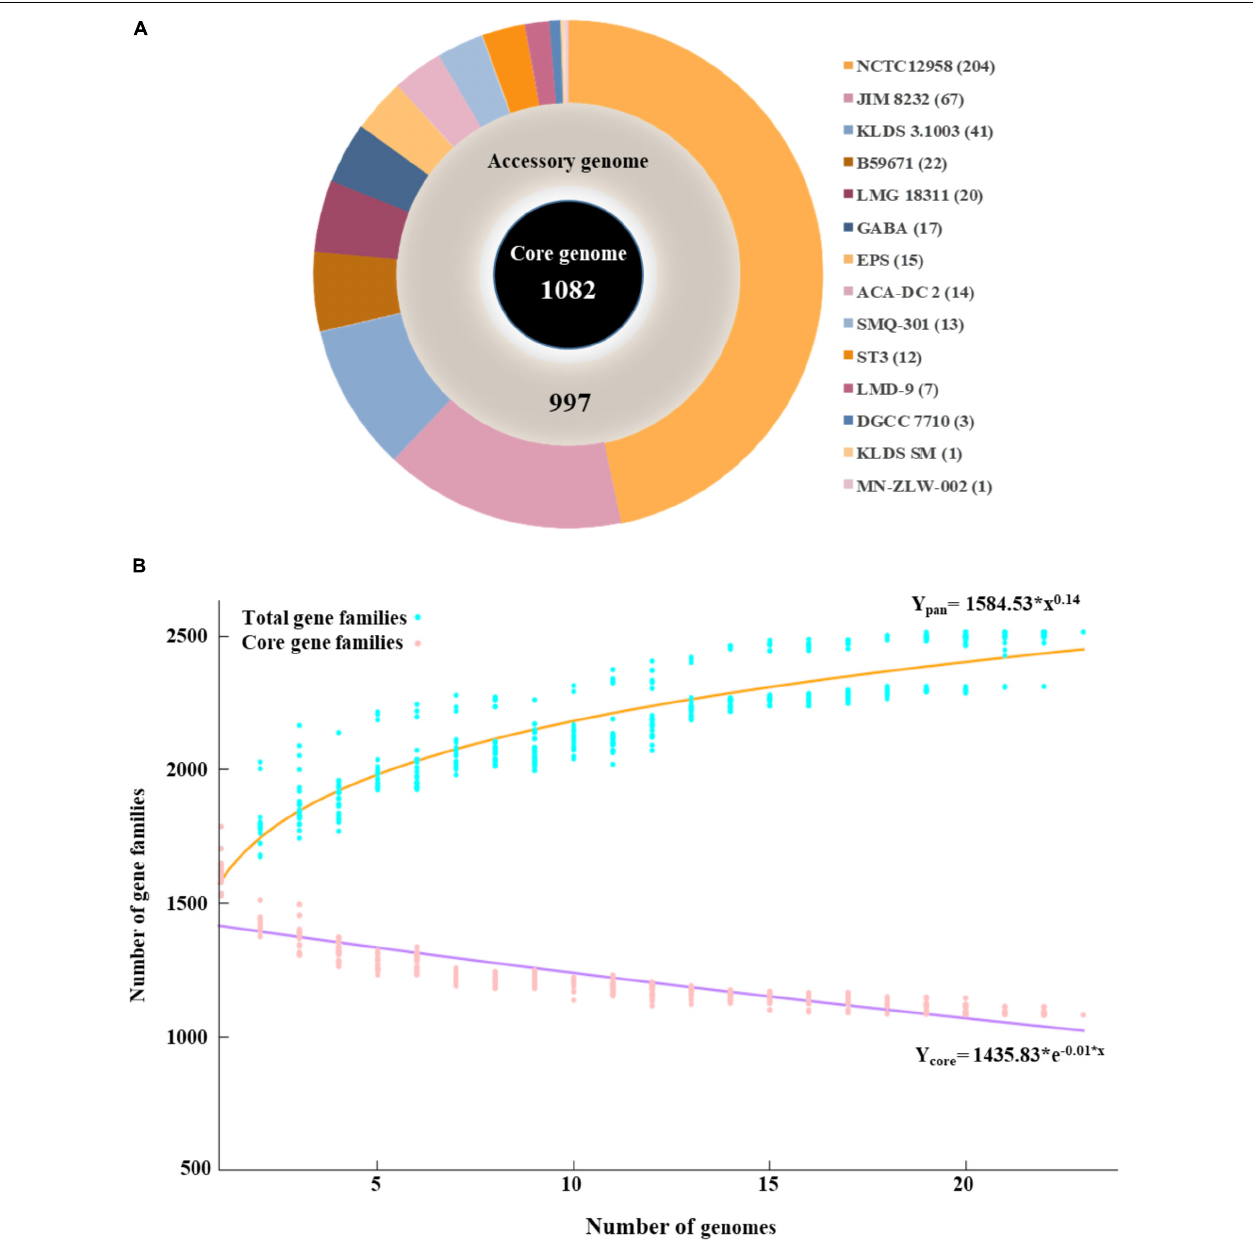
FIGURE 1 | Graphical presentation of core genome (inner black circle), accessory genome (middle gray circle) and unique genes (outer multicolored circle) of the 23 S. thermophilus strains. The number of unique genes for each strain is presented in the parentheses (A) . Pan and core genome plots of S. thermophilus strains analyzed (B)